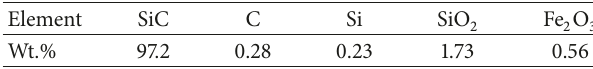
Table 2: Nominal chemical composition of